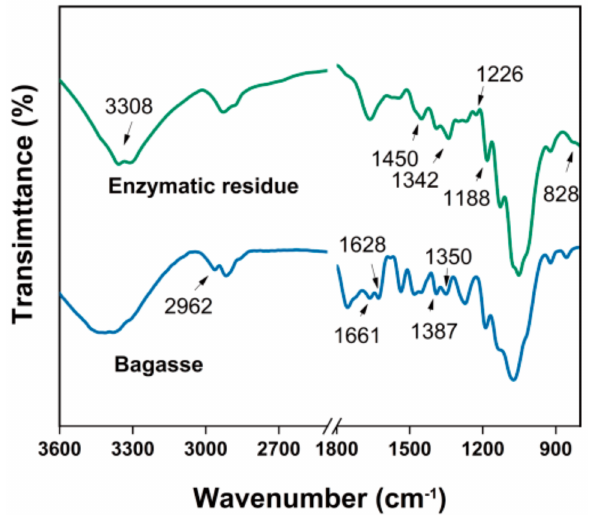
Figure 1. Fourier transform infrared (FTIR) spectra of the bagasse and its residue after enzy- matic hydrolysis.